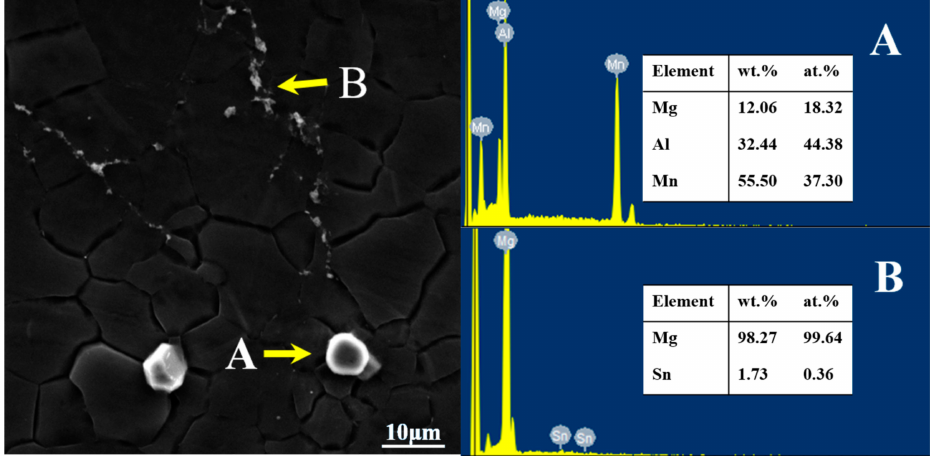
Figure 7. The EDS results of the main phase in the as-extruded AT71-0.4Mn alloy. ( A ) Al-Mn phase; ( B ) Mg 2 Sn.